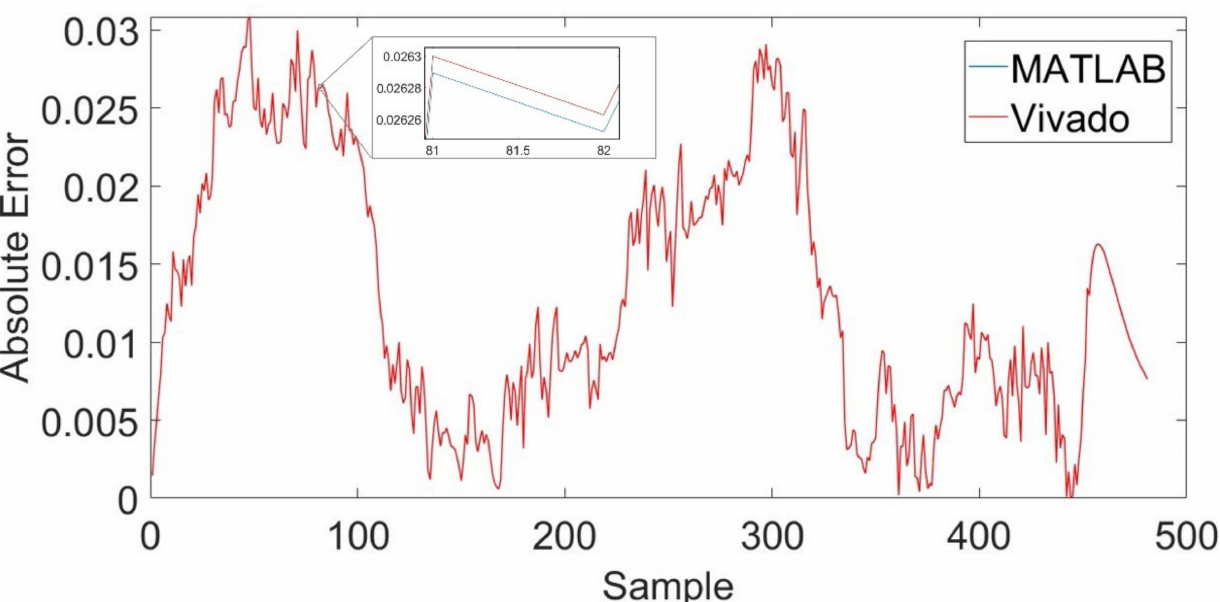
Figure 2. SoC estimation AE in MATLAB floating point-based simulations and Vivado fixed-point-based behavioral simulations.